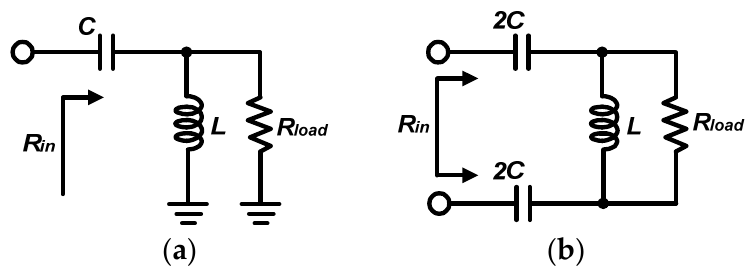
Figure 4. Simple LC-type impedance matching networks. ( a ) Single-ended. ( b ) Differential.